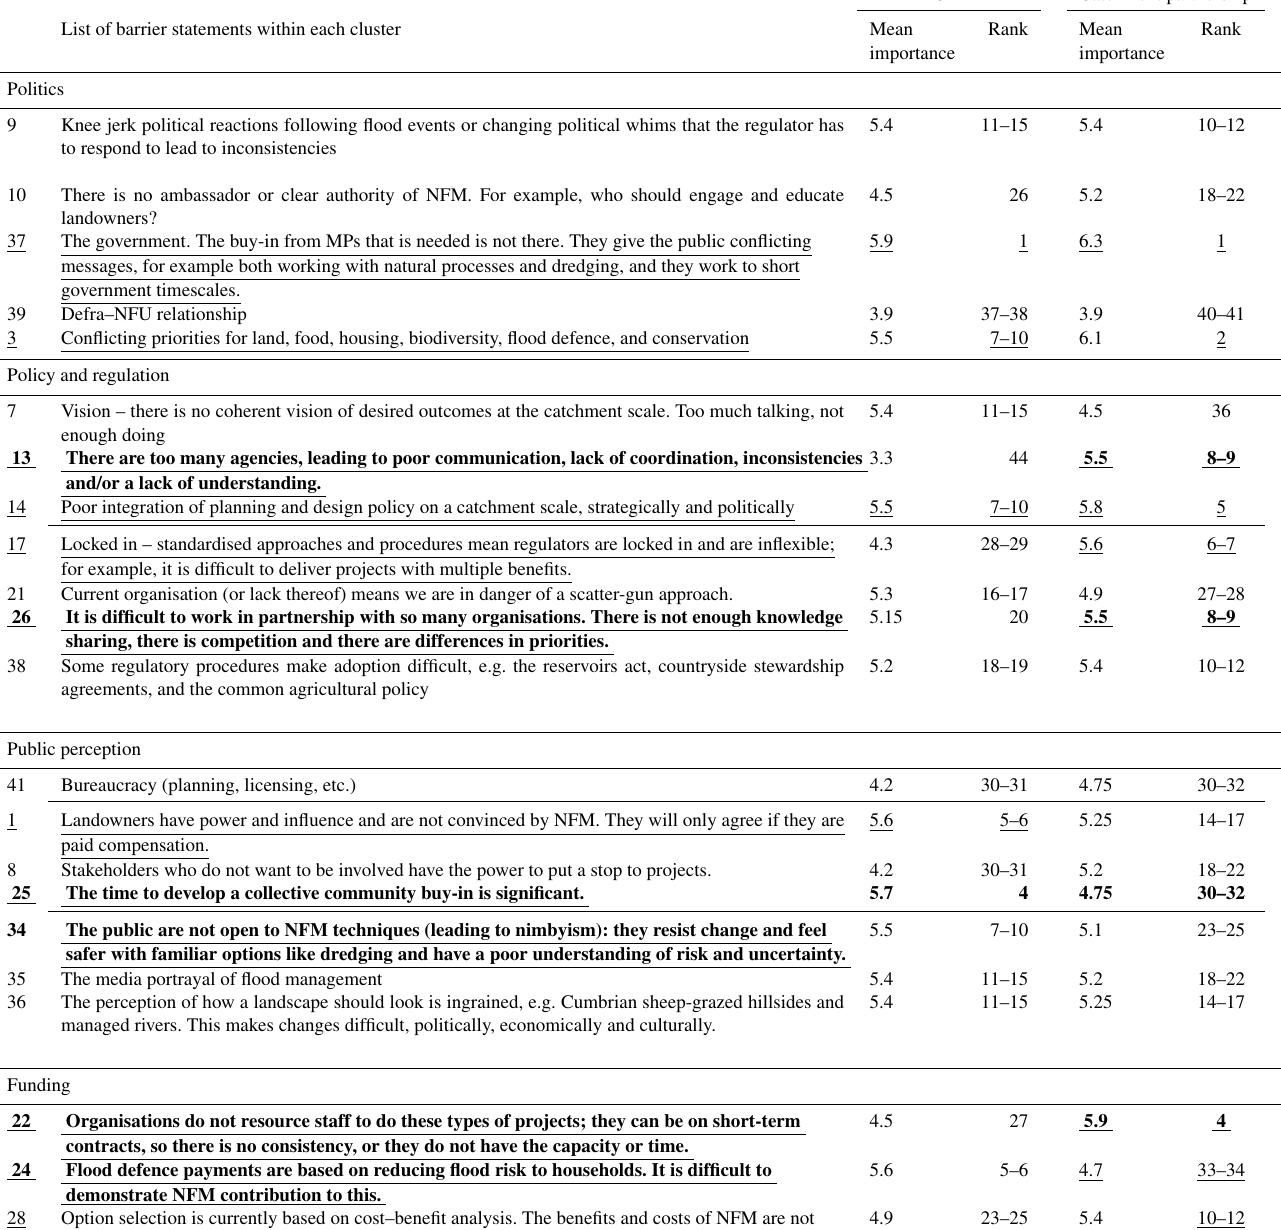
Table A1. Forty-seven individual barrier statements generated via phase 1. Qualitative statement generation, sorted into seven concepts in phase 2, mean importance and rank according to practitioner groups. The top 10 barriers are underlined to highlight them. Those in bold typeface indicate a large difference in perceptions between the two actor